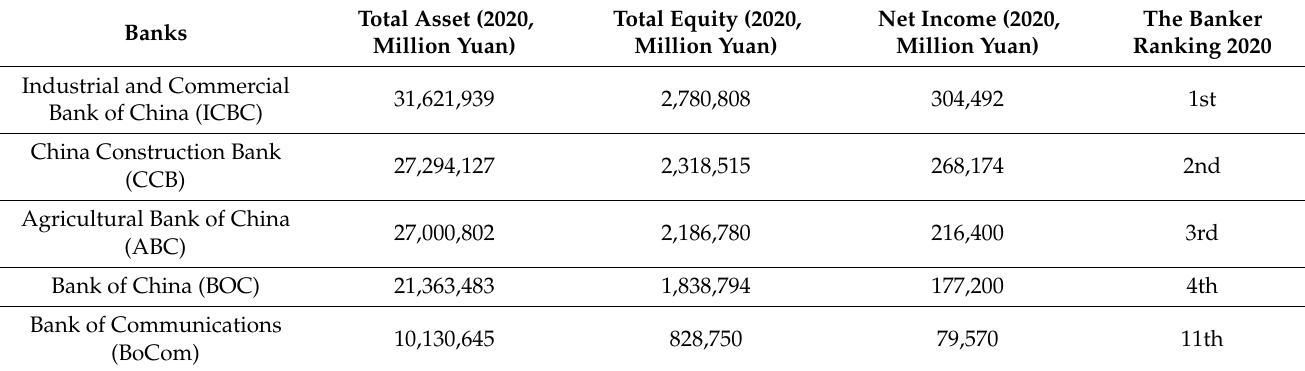
Table 1. Basic information of “Big Five” Chinese State-owned commercial